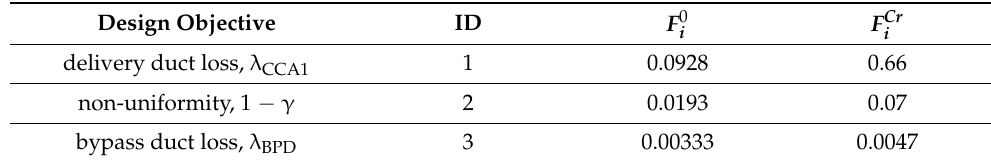
Figure 14. Effect of fan tip pressure ratio and bypass duct pressure losses on fan equivalent polytropic efficiency, (from Kyprianidis [29]). Table 3. Scaling parameters for DoE 1.